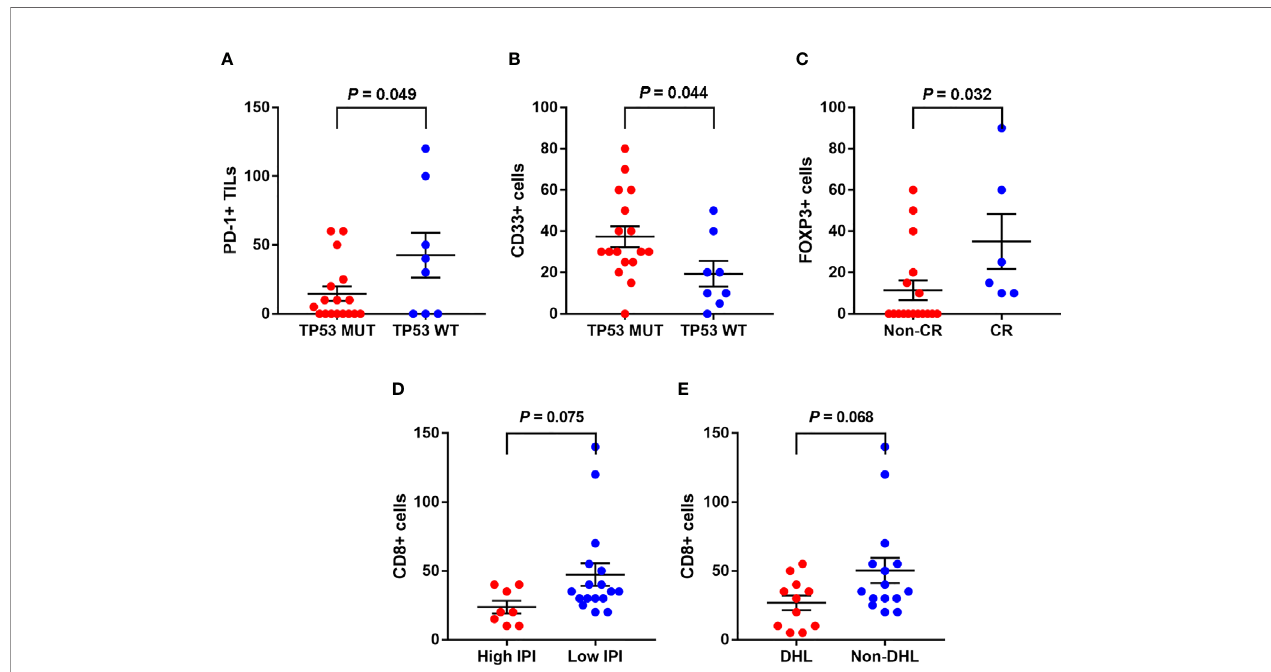
FIGURE 3 | Associations between clinicopathological features and the tumor immune microenvironment markers in A-DLBCL. There were less PD-L1 + TILs in TP53 mutant cases than in TP53 wild type cases (A) , the result was opposite as to CD33 + cells (MDSCs) (B) . Patients with less Treg cells (10.3 ± 4.5/HPF vs 35 ± 13.4/ HPF, P=0.032) in TME (FOXP3) ended in non-complete response (CR) to chemotherapy (C) . CD8 + cells showed a trend of decreasing in number in patients with high International Prognostic Index (IPI) score (D) . CD8 + cells showed a trend of decreasing in patients with double-hit lymphoma (DHL) (E) .